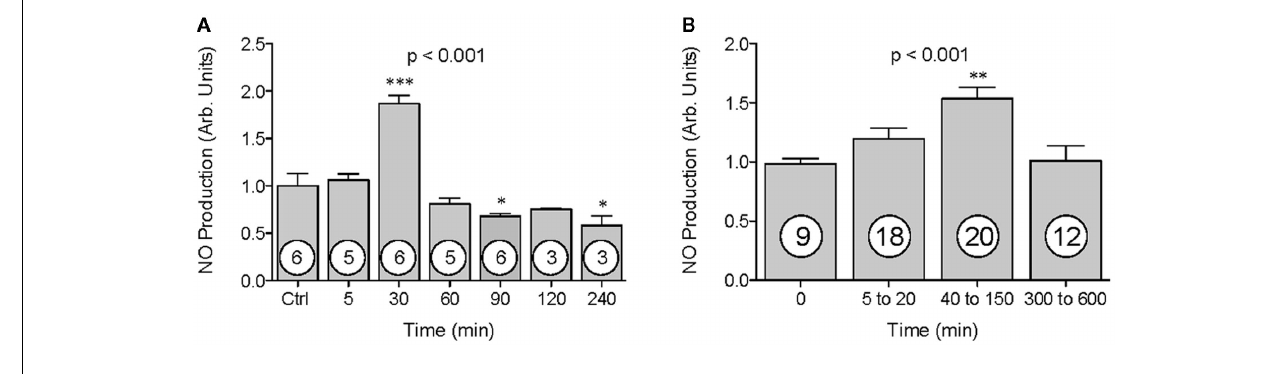
performed using a one-way ANOVA (ANOVA p -value is in center of figure) with Dunnett’s post hoc test. Numbers inside circles denote the N for each column. An asterisk denotes values significantly different from control by post hoc test. * p < 0.05, ** p < 0.01, *** p < 0.001.